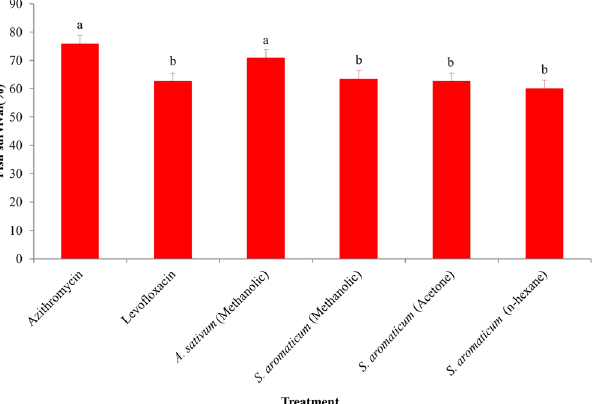
Figure 6. Average survival rate (therapeutic effects) of O . niloticus fed with medicinal plant extracts and commercial antibiotics after infection challenge by a high virulent strain of E . faecalis . One way ANOVA was performed for analysis of the data and mean values in the bars followed by the same letter(s) are not significantly different as assessed by LSD (least significance difference) at p ≤